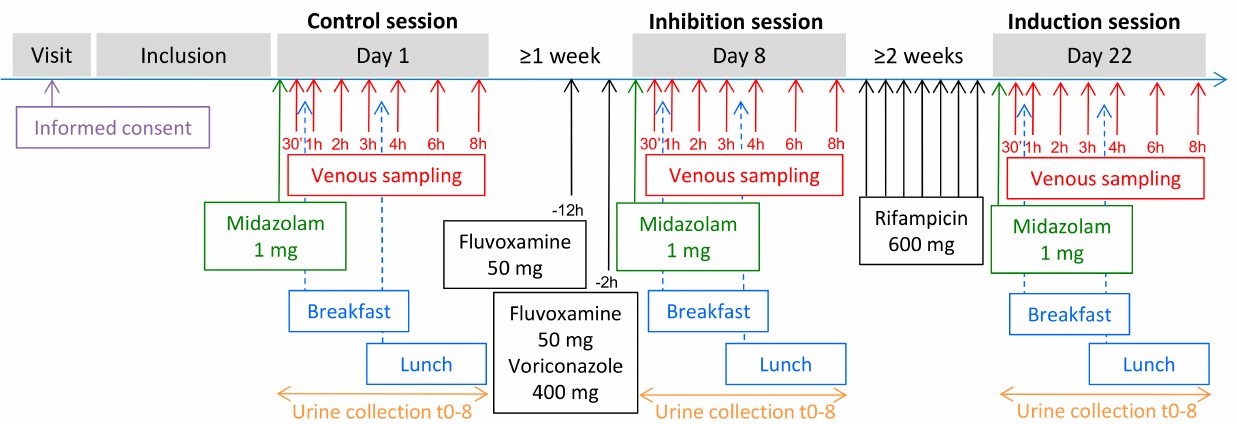
Figure 1. Study timeline. Midazolam 1 mg, as part of the Geneva cocktail, was orally administered on days 1, 8, and 22. Fluvoxamine 50 mg was administered 12 h and 2 h before the administration of midazolam (inhibition session). Voriconazole 400 mg was administered 2 h before the administration of midazolam (inhibition session). Rifampicin 600 mg was administered once daily for seven days until the evening before the administration of midazolam (induction